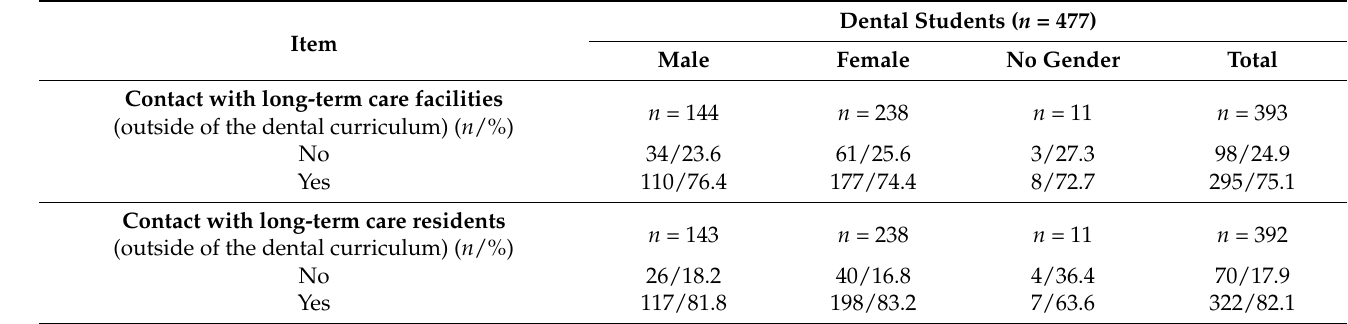
Table 1. Student experience with long-term care facilities and long-term care residents. (* experience in care = means both professionally in the context of an education or learned profession or as a layperson) (different n as total: not all students responded to all